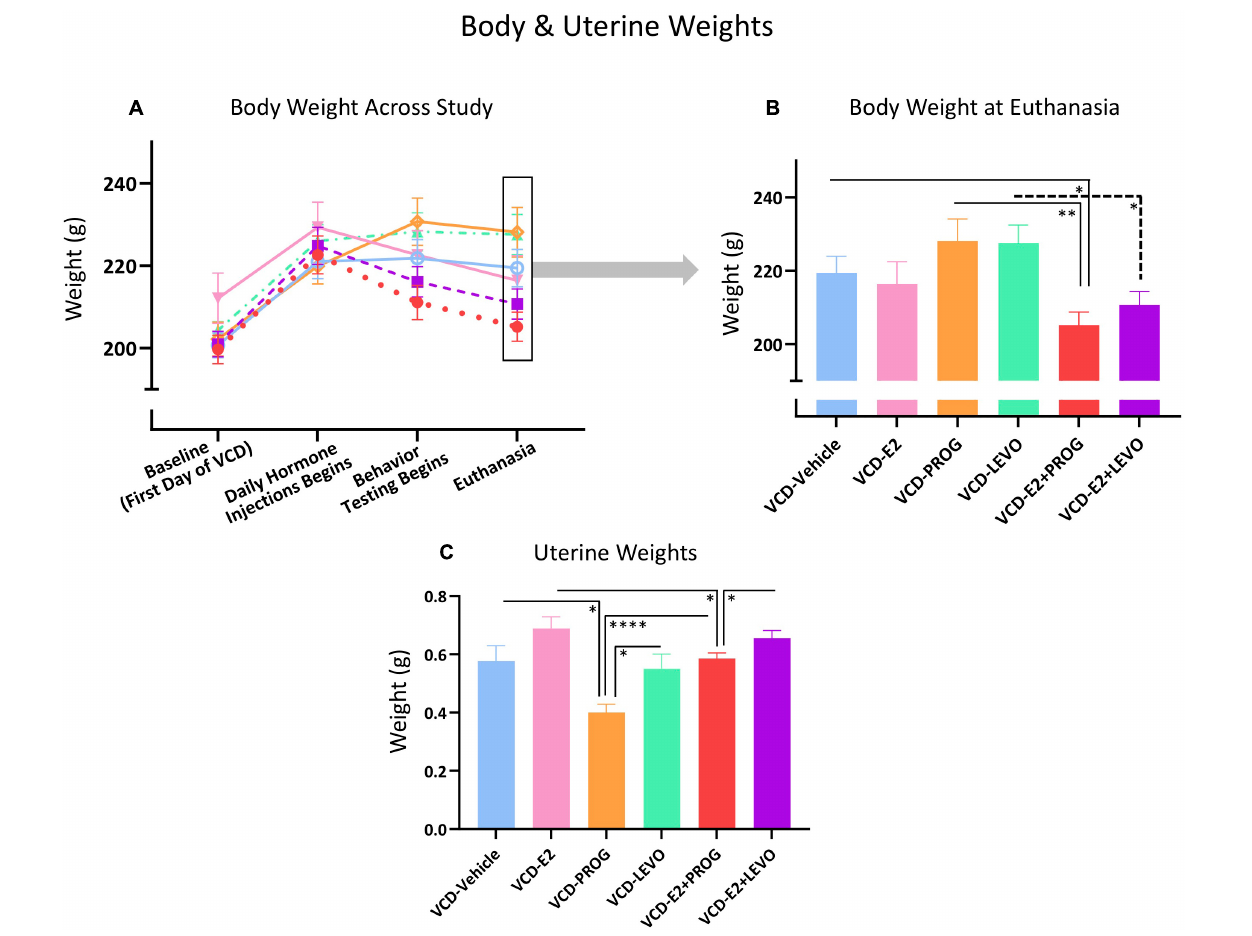
FIGURE 14 | Peripheral markers of overall health and uterine stimulation. (A) Body weight changes across the experimental timeline (B) At the end of the experiment, the VCD-E2 + PROG group weighed less than the VCD-Vehicle group and the VCD-PROG group, suggesting combination hormone therapy promotes weight maintenance compared to no hormone therapy treatment or progesterone treatment alone. The VCD-E2 + LEVO group also weighed less than its VCD-LEVO alone counterpart, again suggesting combination hormone therapy promotes weight maintenance. (C) PROG treatment reduced uterine weight compared to VCD-Vehicle, VCD-LEVO, and VCD-E2 + PROG groups. VCD-E2 + PROG uterine weight was attenuated compared to VCD-E2 treatment along, suggesting progesterone blocked uterine proliferation. The VCD-E2 + LEVO group uteri weighed more than those in the VCD-E2 + PROG group, indicating less progestin-induced attenuation of uterine stimulation compared to natural progesterone when in a combined hormone therapy regimen. Significance: ∗ = p < 0.05, ∗∗ = p < 0.01, ∗∗∗∗ = p <